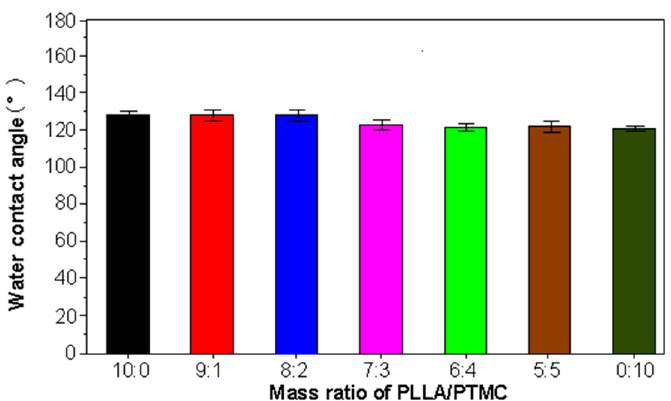
Figure 6. Measured water contact angle values for PLLA/PTMC blend membranes characterised by different blending ratios. p < 0.05; error bars indicate SD; n = 3.